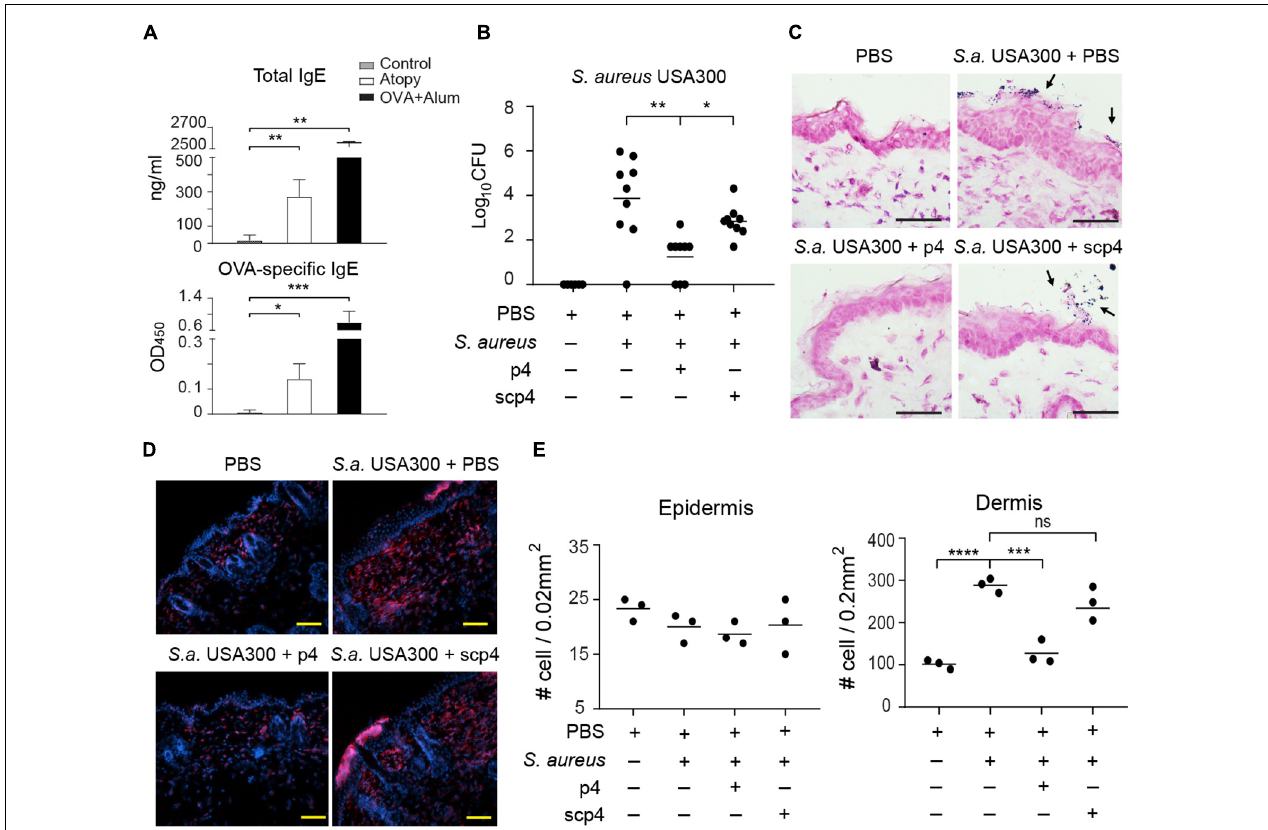
FIGURE 5 | p4 reduces MRSA burden and accompanying skin inflammation in the experimental model of AD. Mice were subjected to tape-striping and OVA challenge to induce an AD-like phenotype (Atopy). (A) Allergic changes were monitored by ELISA specific for total or OVA-specific serum IgE levels, upper and lower panels, respectively. The negative control represents sera from sex- and aged-matched unchallenged mice (control). The positive control represents sera of mice immunized i.p. with OVA in the presence of alum adjuvant for 10 days (OVA+Alum). The antibody titers are shown as mean ± SD ng/ml or OD (optical density units) for the indicated sets of sera. n = 4–5, *** p < 0.001; ** p < 0.01; * p < 0.05 by Kruskal–Wallis test with post hoc Dunn’s multiple comparisons test. (B) Mice were subjected to tape-striping and OVA challenge, followed by bacterial challenge and/or treatment with the indicated factors. Data points indicate the number of live bacteria recovered from the skin surface 24 h after application of S. aureus , n = 8. ** p < 0.01; * p < 0.05 by the Kruskal–Wallis test with post hoc Dunn’s multiple comparison test. (C) Representative Gram staining of the indicated skin biopsies from the AD model. S. aureus on the skin surface is indicated by arrows . (D) Representative fluorescence microscope images of the indicated AD skin, stained with Hoechst to detect DNA (blue) and anti-CD45 to identify leukocytes (red). (E) Data points indicate # of leukocytes (CD45+) infiltrating the indicated area of AD skin, n = 3 mice per group. **** p < 0.0001; *** p < 0.001; ns, not significant; by one-way ANOVA with post hoc Dunnett’s multiple comparisons test. Scale bar = 20 µ